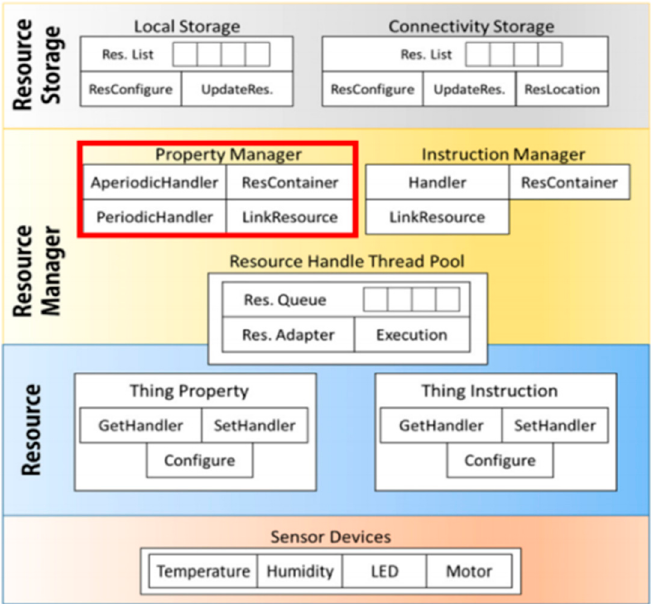
Figure 1. MinT resource management architecture. Res.: resource; LED: Light Emitting Diode.